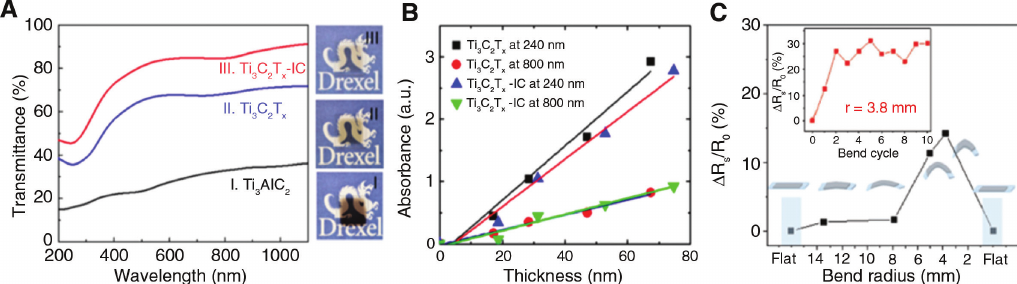
Figure 11: The transmittance spectra and the ight absorbance of several MXenes and the change of film’s resistance upon bending. (A) Transmittance spectra with their corresponding images for Ti Verlag GmbH & Co. KGaA, Weinheim. (B) Light absorbance of Ti upon bending. Adapted with permission from [118], Wiley-VCH Verlag GmbH & Co. KGaA,